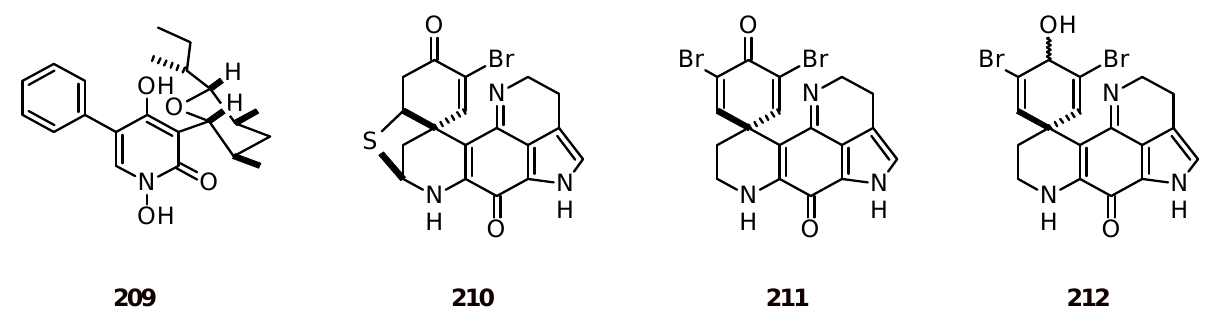
Figure 23. Structures of alkaloids 209 - 212 .